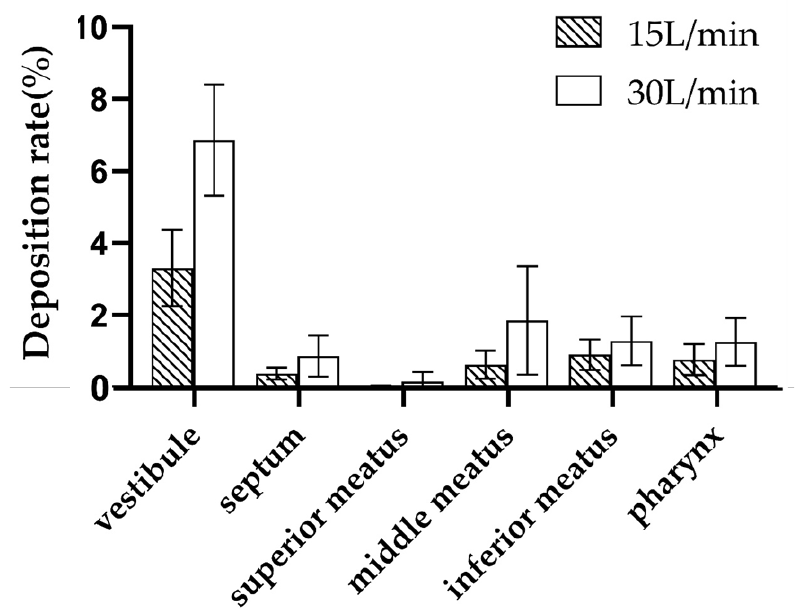
Figure 6. Deposition rates of A. niger spores at each anatomical area in nasal cavity under 15 L/min and 30 L/min inspiratory conditions.